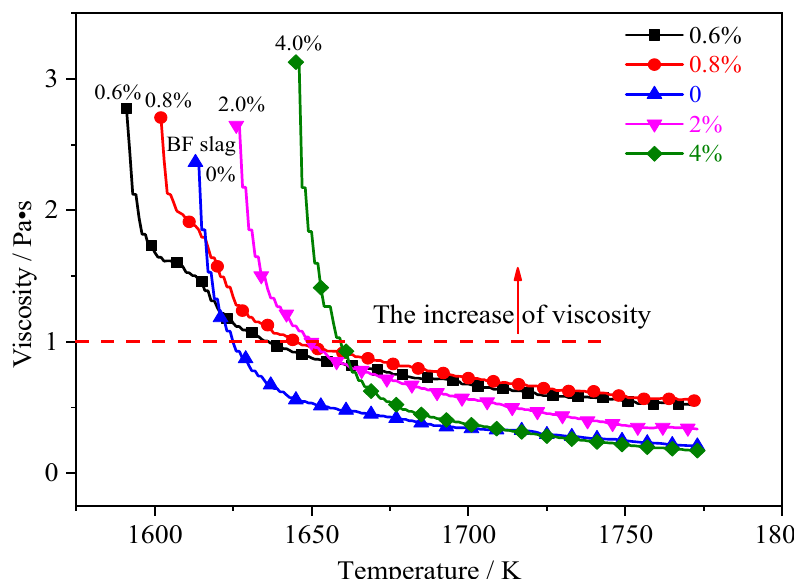
Figure 5. Viscosity of the slag as a function of the temperature for different UPC contents (0%, 0.6%, 0.8%, 2% and 4%).